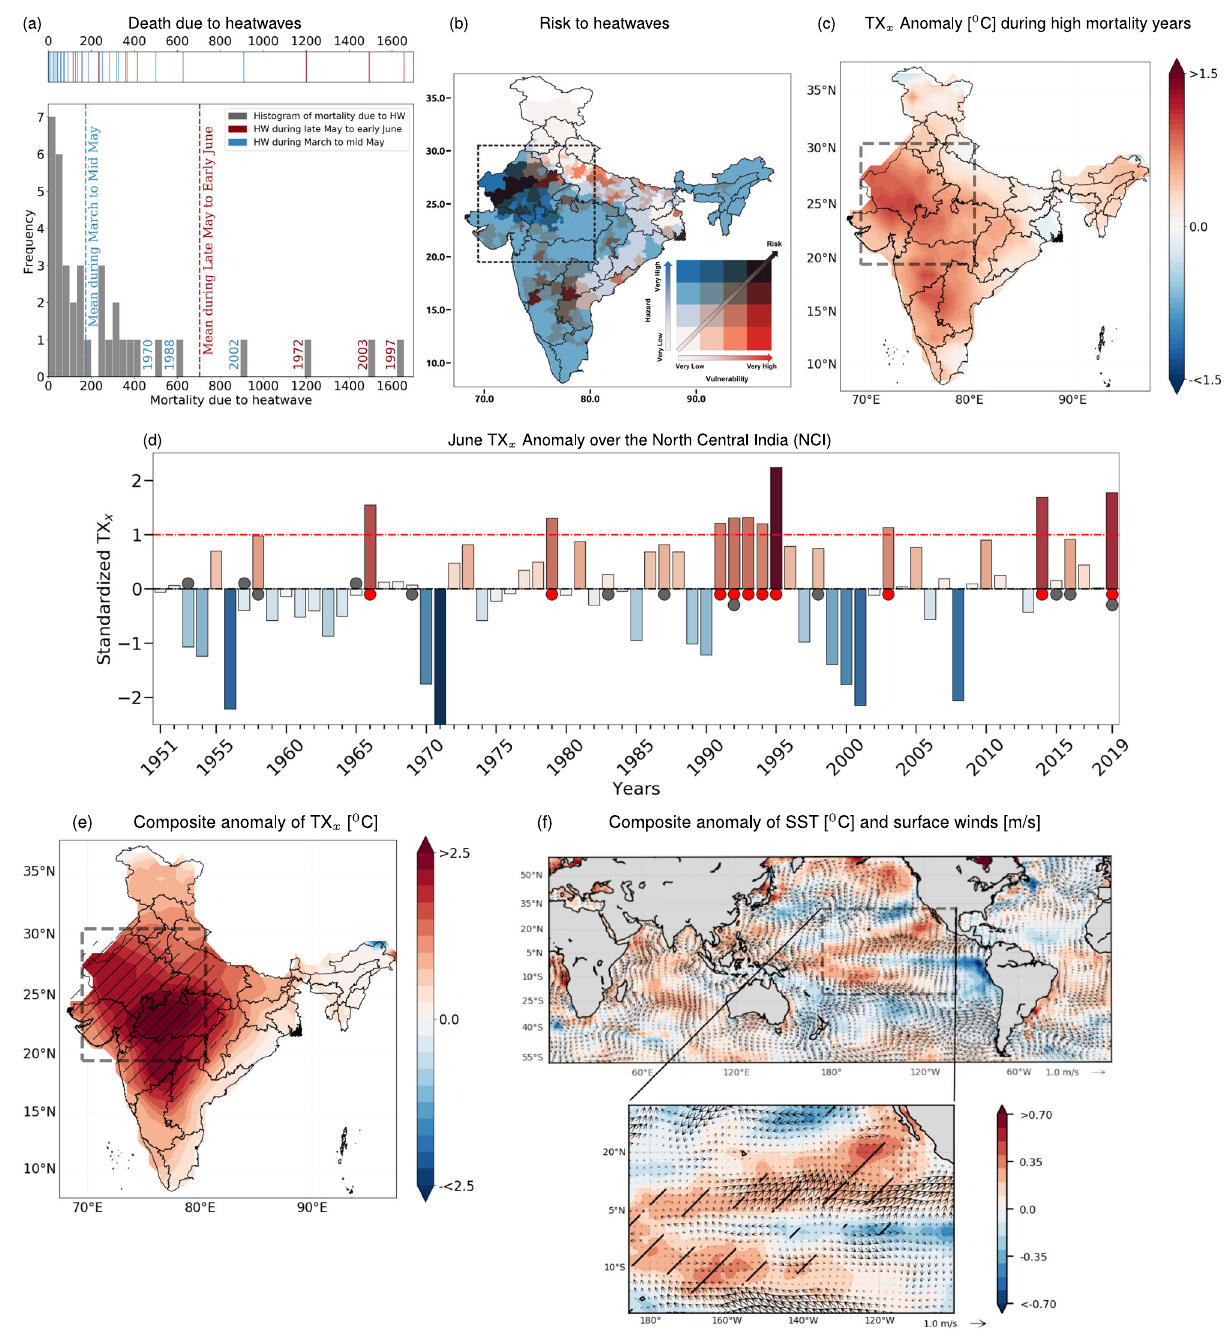
Fig.1|Summerheatwavevariability(June)acrosstheNorthCentralIndia(NCI) and corresponding large-scale atmospheric and sea surface dynamics. a Mortality due to heatwaves over India. Shown are the histogram of mortality to heatwaveswhereastheyearswithmajorheatwavesareindicatedinthetoppanelof a whereinthered(blue)coloredlineindicatestheheatwaveoccurrenceduringlate May – June (March – mid May). The red (blue) colored vertical dashed lines in the histogram represents the mean moratality coinciding during late May – June (March – mid May) periods (see Supplementary Note 1 for more details). b Multi- variate risk (heatwave hazard×vulnerability) map during the period 2011 over India. The 4×4 bivariate choropleth in the inset of map shows the classi fi cation of theriskbasedonthehazardandvulnerabilityvalues(seeSupplementaryNote2for the vulnerability and hazardestimations).The black rectangular box represent the highheatwaveriskproneregionofNorthcentralIndian(NCI). c Heatwaveintensity (TX x ) anomaly for the summer (June) during deadly (high heat-related mortality)